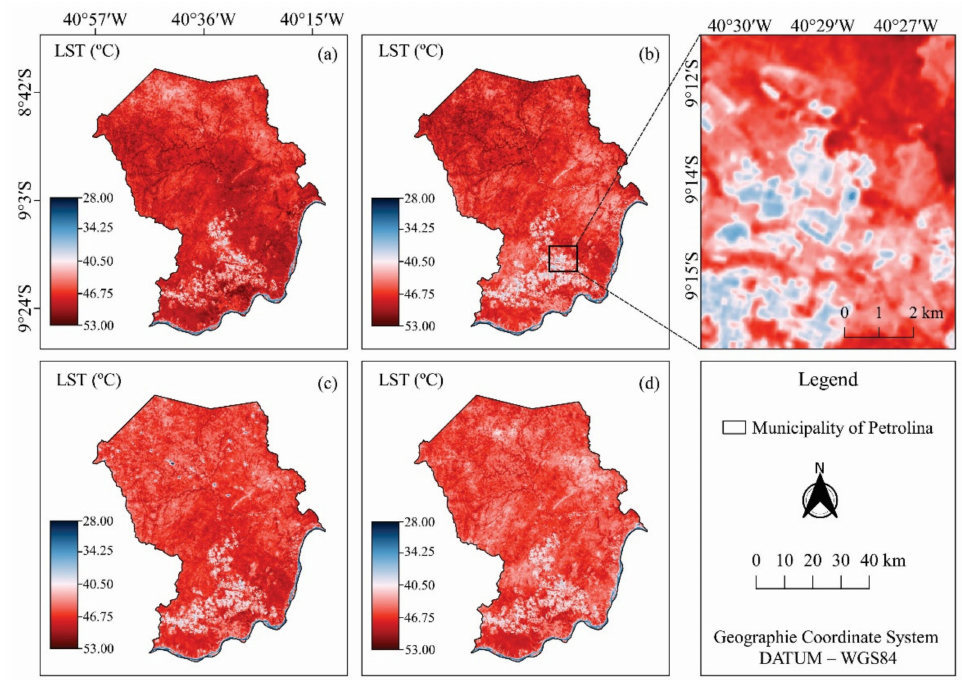
Figure 8. Spatiotemporal distribution of the land surface temperature—LST ( ◦ C) in the municipality of Petrolina, Pernambuco, Brazil, on the imaging dates 5 October 2013 ( a ), 12 November 2015 ( b ), 16 October 2017 ( c ) and 7 November 2019 ( d